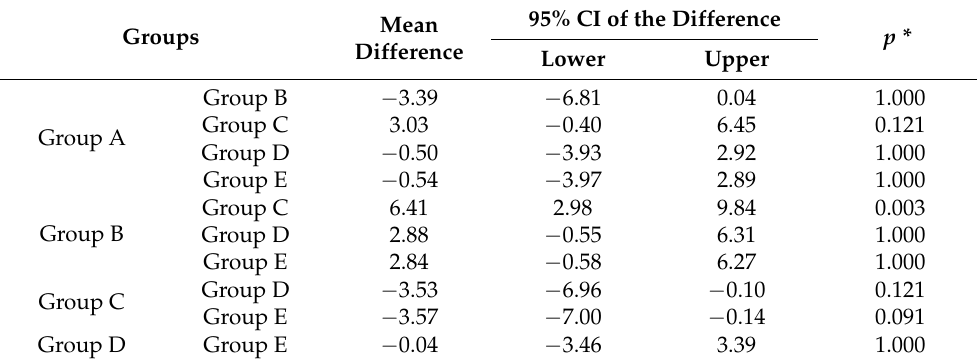
Table 6. Multiple comparison between the different groups tested. Groups